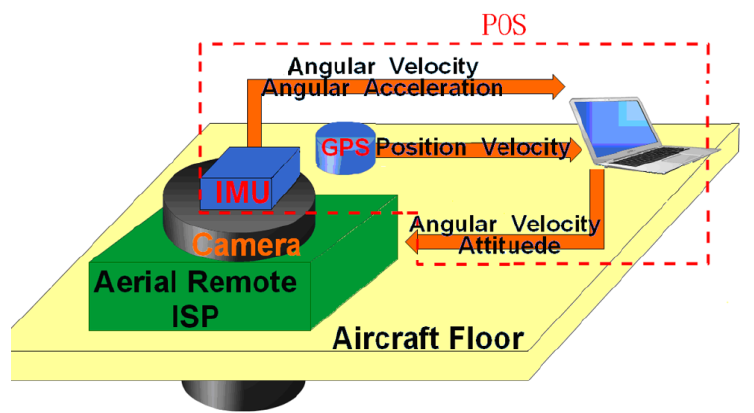
Figure 1. Schematic diagram of an aerial remote sensing system.